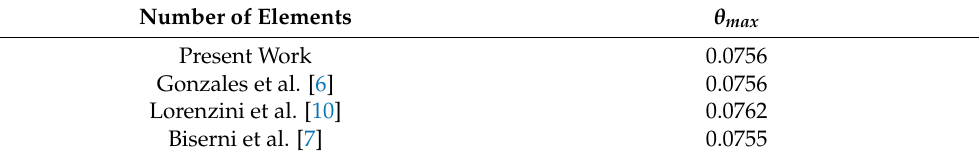
Table 2. Validation of the computational method used in present work with references in the literature [6,7,10]. Number of Elements θ